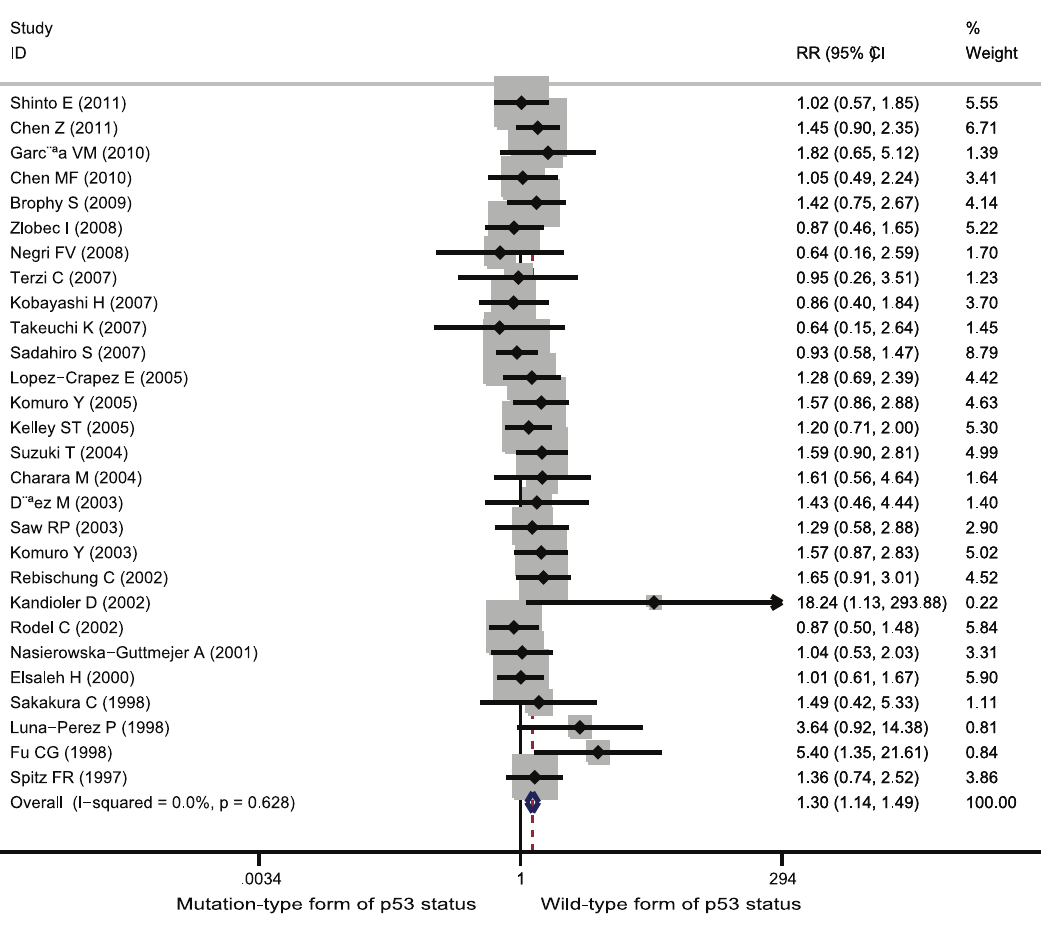
Figure 2. Forest plots of RR were assessed for association between p53 and good response among rectal cancer patients treated with neoadjuvant radiation-based